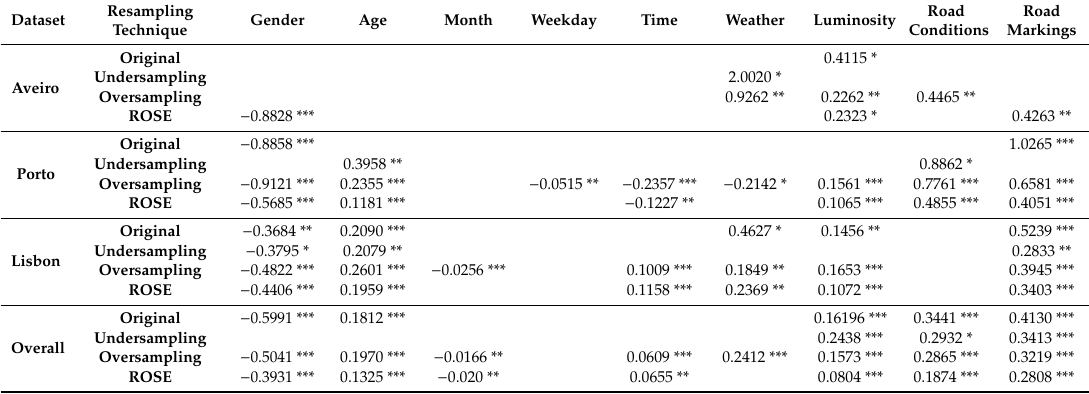
Table 5. Statistically significant variables for pedestrians considering the logistic regression